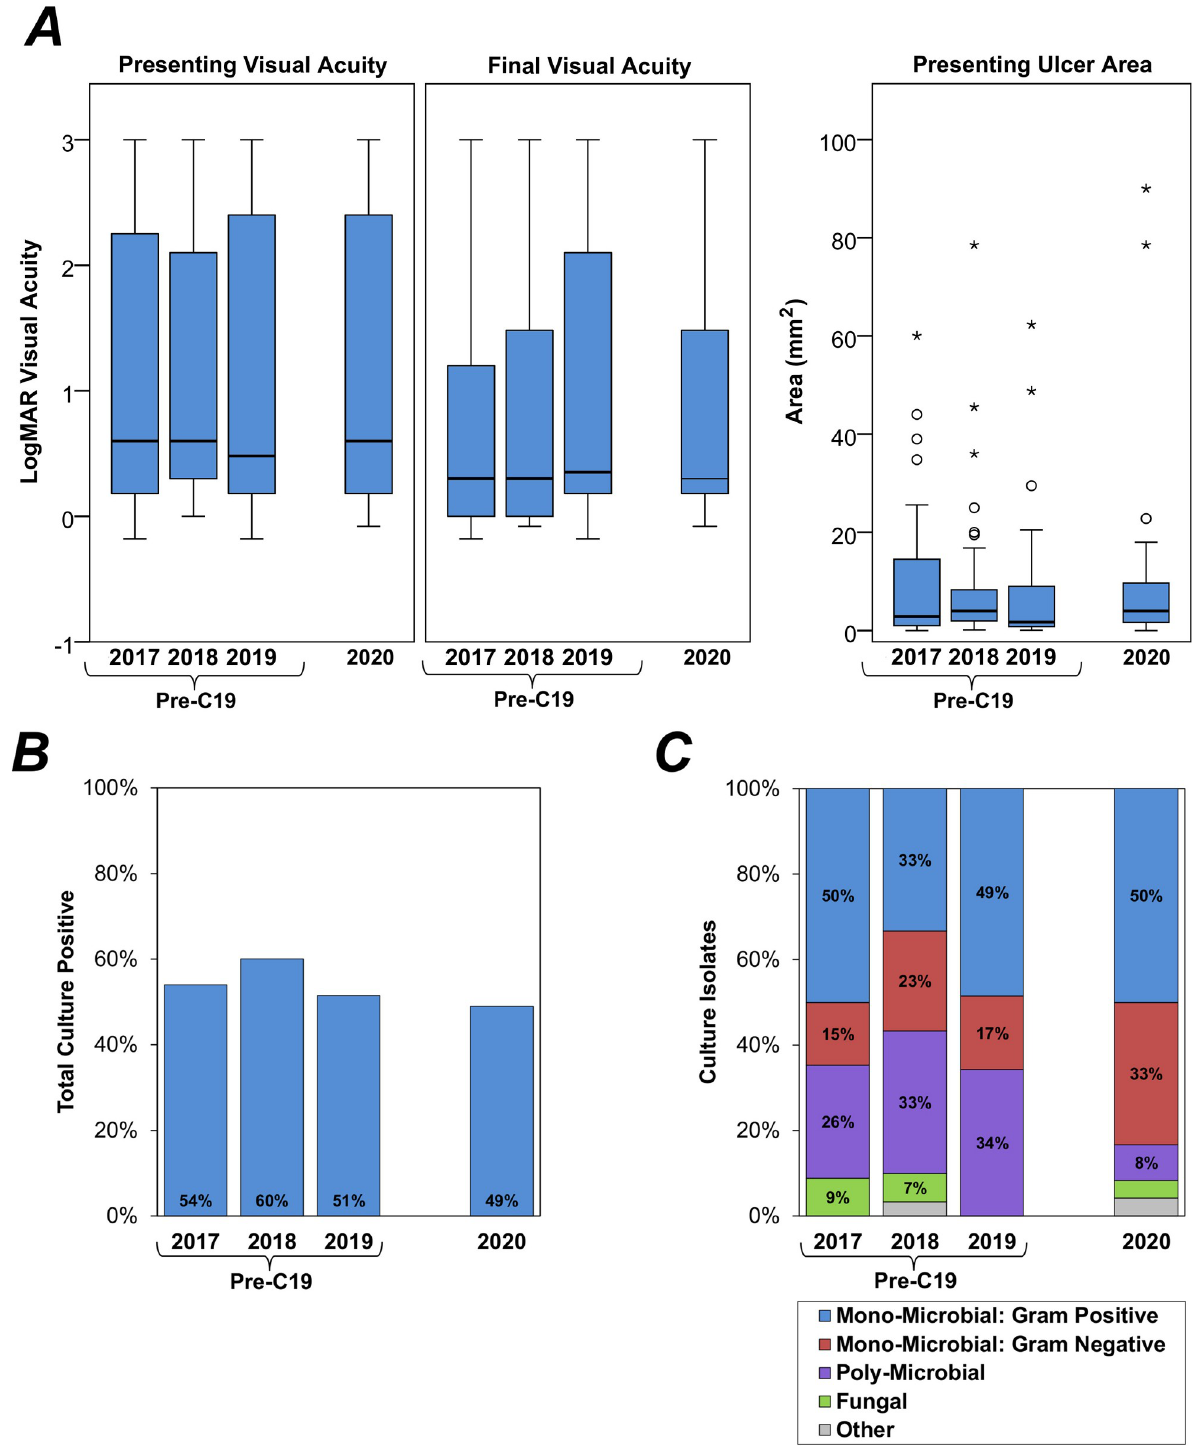
Fig 1. Clinical assessments and microbiology by year of admission. Clinical assessments (Fig 1A) are summarised using boxplots, with outliers indicated with circles or asterisks for those outside the box by 1.5- or 3-times the interquartile range, respectively. Microbiology is summarised as the total proportion of the cohort that were culture positive (Fig 1B), and the distribution of culture isolates from these positive cases (Fig 1C); unlabelled bars consist of < 5% of cases. Further details of the definitions used for the microbial cultures are reported in Table 4.